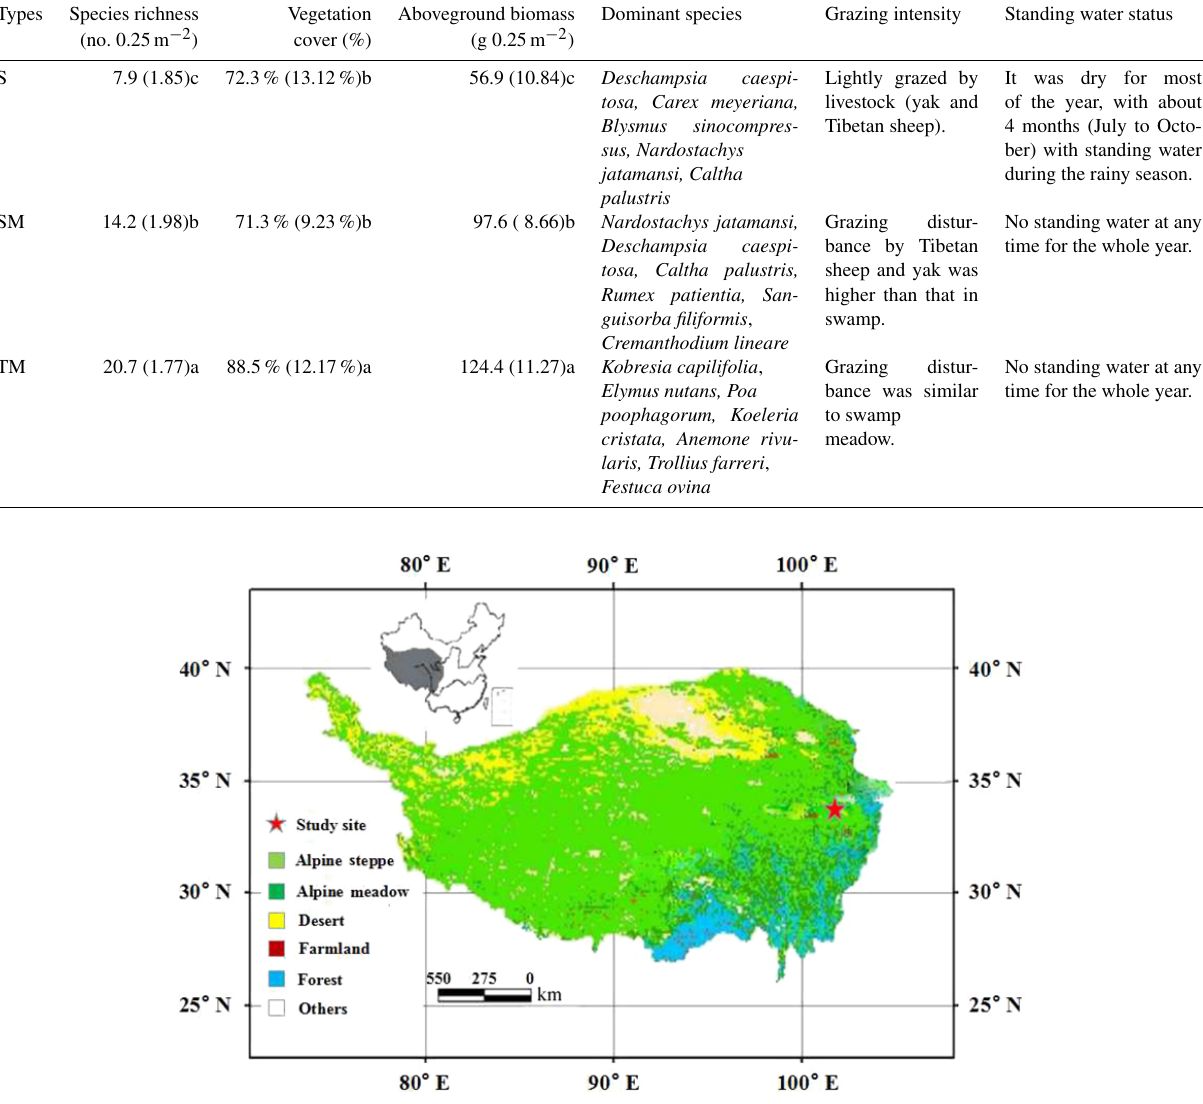
Figure 1. The location of the Tibetan Plateau in China and our study site (the Research Station of Alpine Meadow and Wetland Ecosystems of Lanzhou University) at the Tibetan